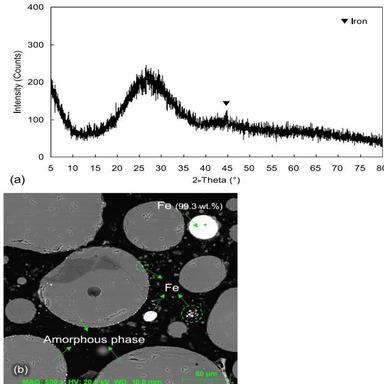
(a) XRD pattern of the IGCC slag sample, which indicated that the IGCC slag was amorphous. (b) Backscattered electron image obtained during FE-SEM analysis showing characteristic features of IGCC slag. The gray spherical particles correspond to the poorly defined amorphous hump in the XRD pattern.